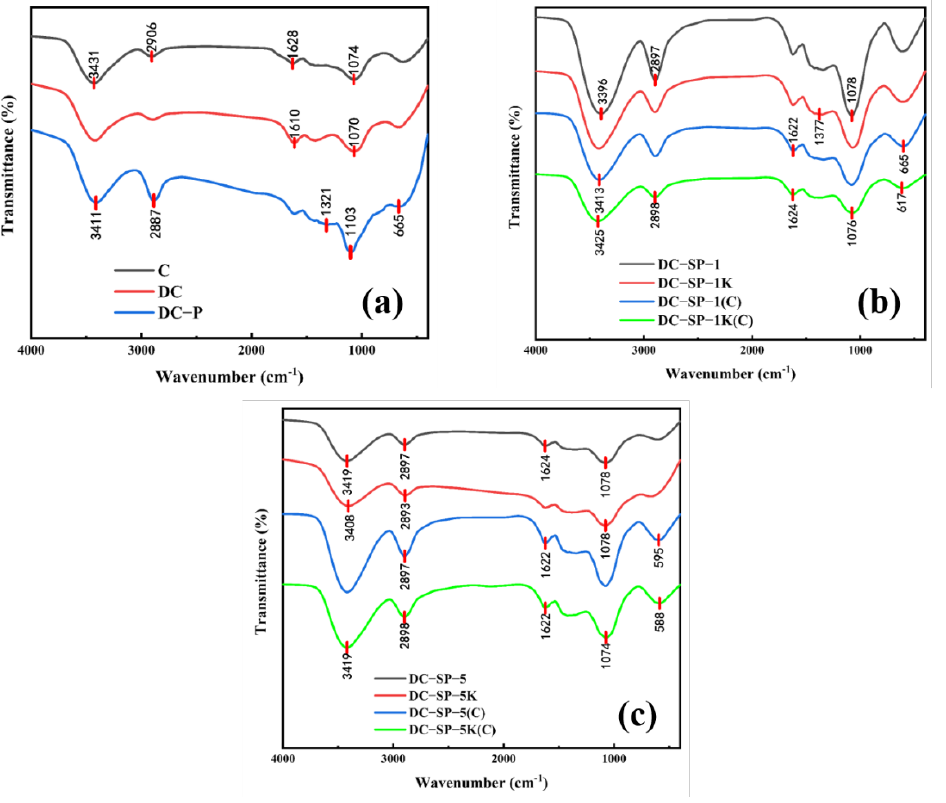
Figure 3. ( a ) FTIR spectral patterns of C, DC, and DC-P; ( b ) DC-SP-1, DC-SP-1K, DC-SP-1(C), and DC-SP-1K(C); ( c ) DC-SP-5, DC-SP-5K, DC-SP-5(C), and DC-SP-5K(C).